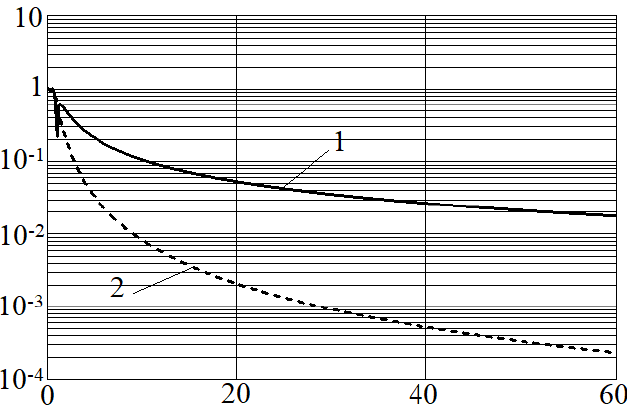
Figure 9. The dependence of the approximation error of the convective term on the number of nodes: 1—difference scheme (38); 2—central difference scheme.